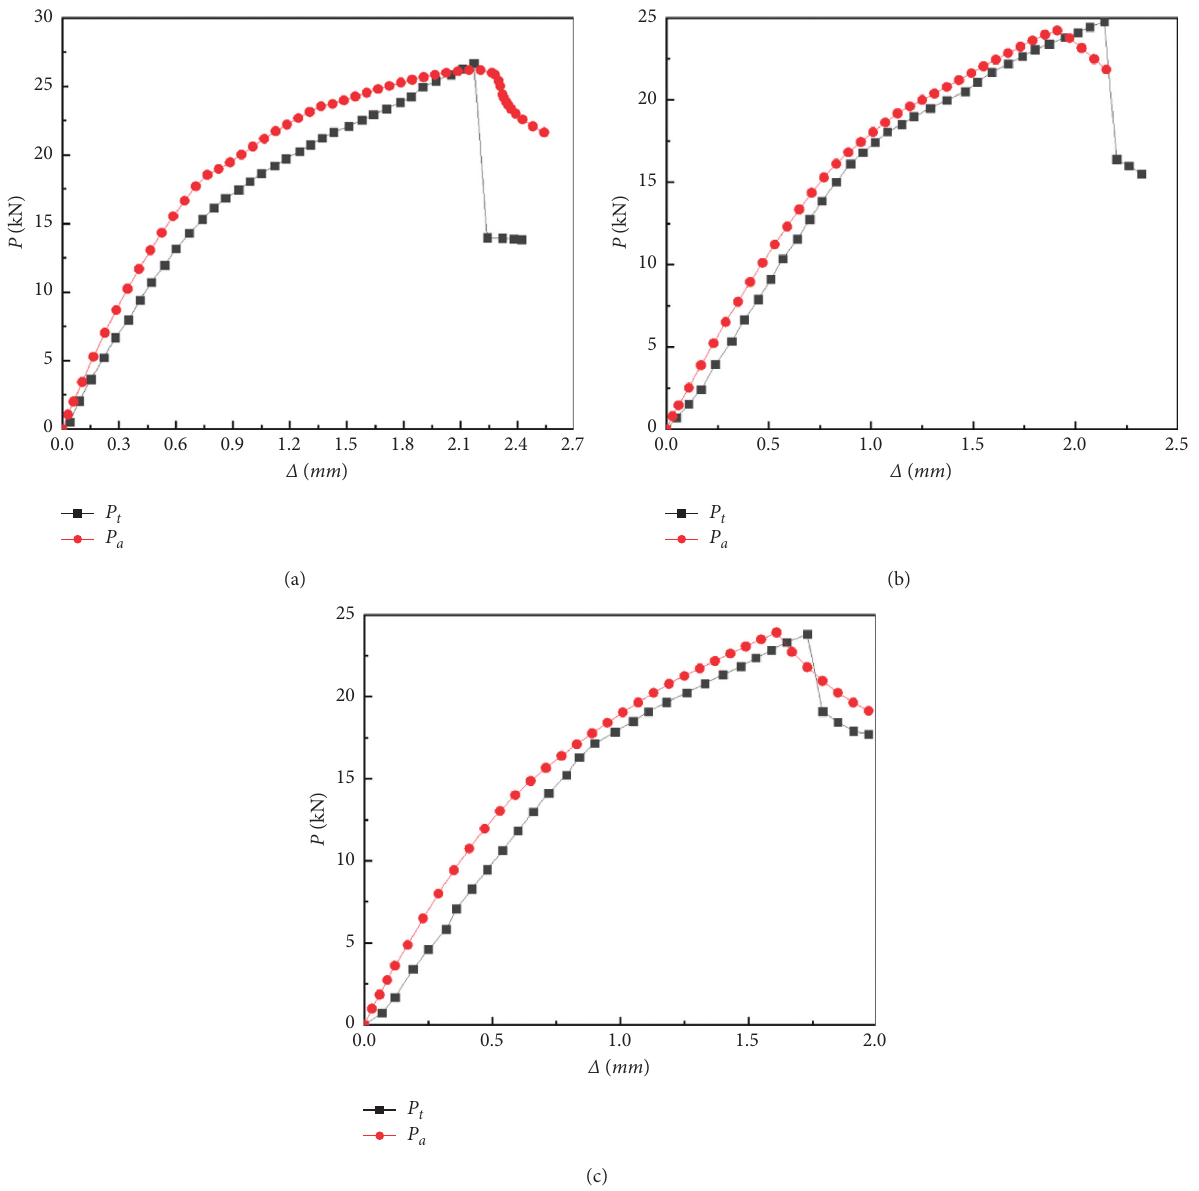
Figure 17: Comparison of load-axial shorten displacement curves of section C80-10 between test and FE analysis. (a) C80-10-2H3-2. (b) C80-10-2H5-2. (c)